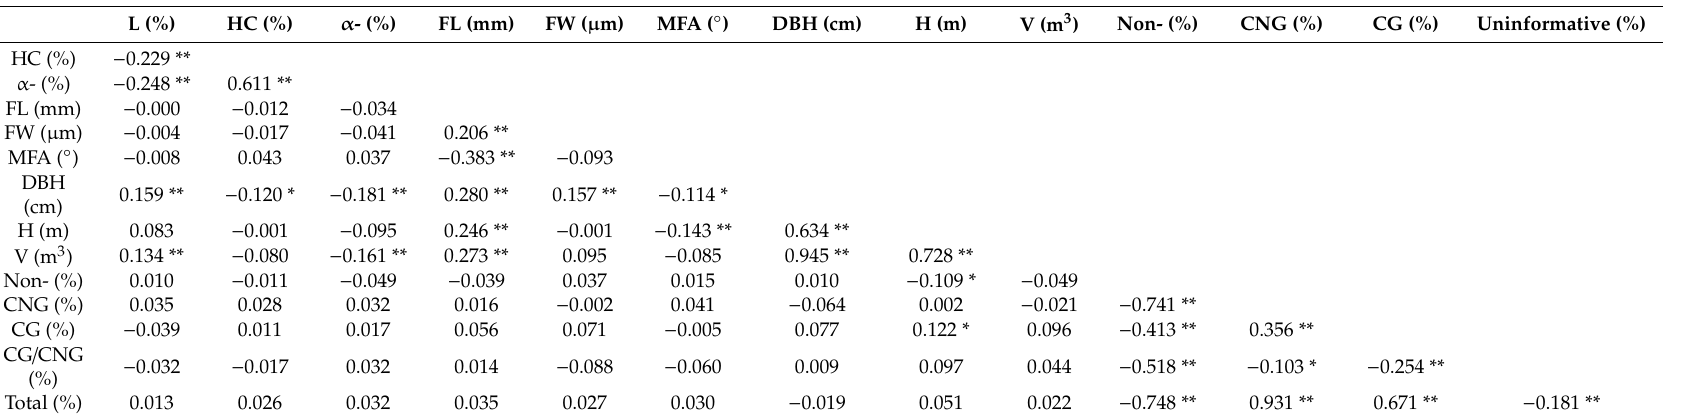
Table 1. Correlations among phenotype parameters and between phenotype and genome methylation / non-methylation levels in the xylem tissue of Populus tomentosa a,b